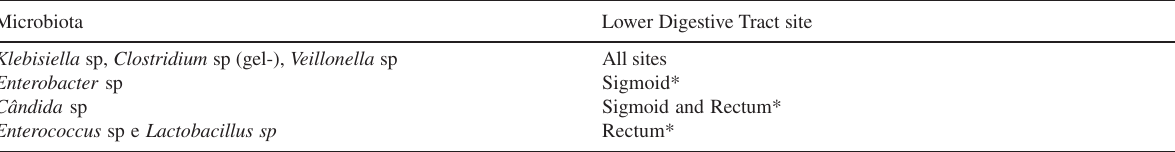
MC = Mean concentration (UFC / Log ), % = prevalence 10 Table 5 - Association between microorganisms/sites of the lower digestive tract Microbiota Lower Digestive Tract site Klebisiella sp, Clostridium sp (gel-), Veillonella sp All sites Enterobacter sp Sigmoid* Cândida sp Sigmoid and Rectum* Enterococcus sp e Lactobacillus sp Rectum* sp = species, * p < 0,05 or <